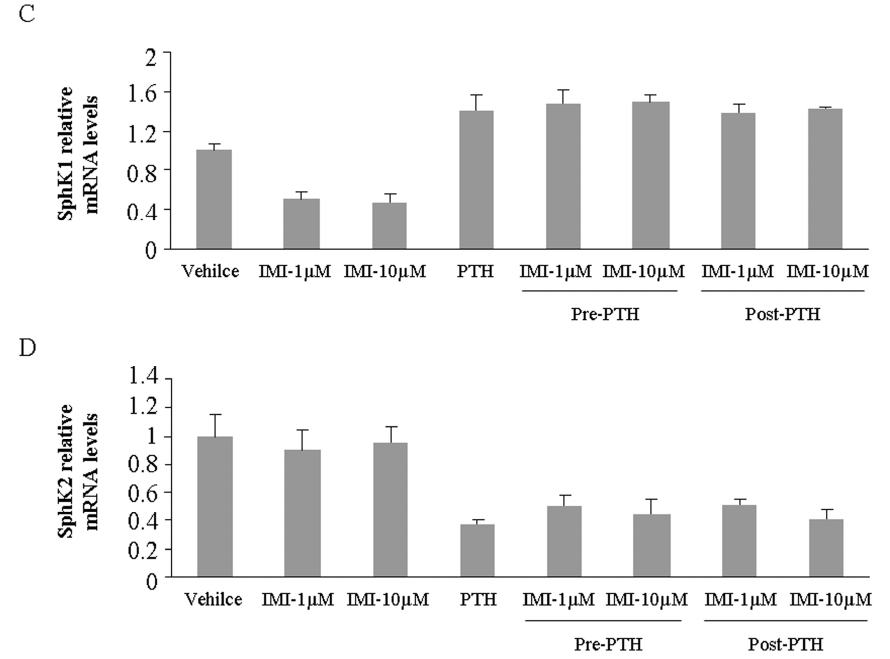
Figure 2. Imipramine regulates genes expression in osteoblasts. ( A ) mRNA expression for RANKL ; ( B ) mRNA expression for OPG ; ( C ) mRNA expression for SphK1 ; ( D ) mRNA expression for SphK2 . Each bar represents the mean ± standard deviation ( n = 3). Vehicle: treatment with PBS; IMI: treatment with imipramine; PTH: treatment with PTH; Pre-PTH: one hour pre-treatment with PTH and then an added imipramine treatment; Post-PTH: one hour imipramine pre-treatment and then an added PTH treatment. PTH